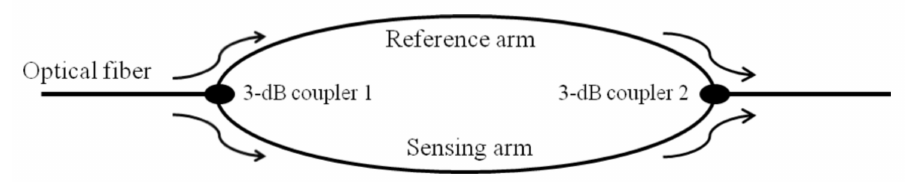
Figure 7. Schematic of an MZI. A beam is split into two arms, the reference and the sensing arms, and then recombined by using two fiber couplers. Reprinted from Ref.